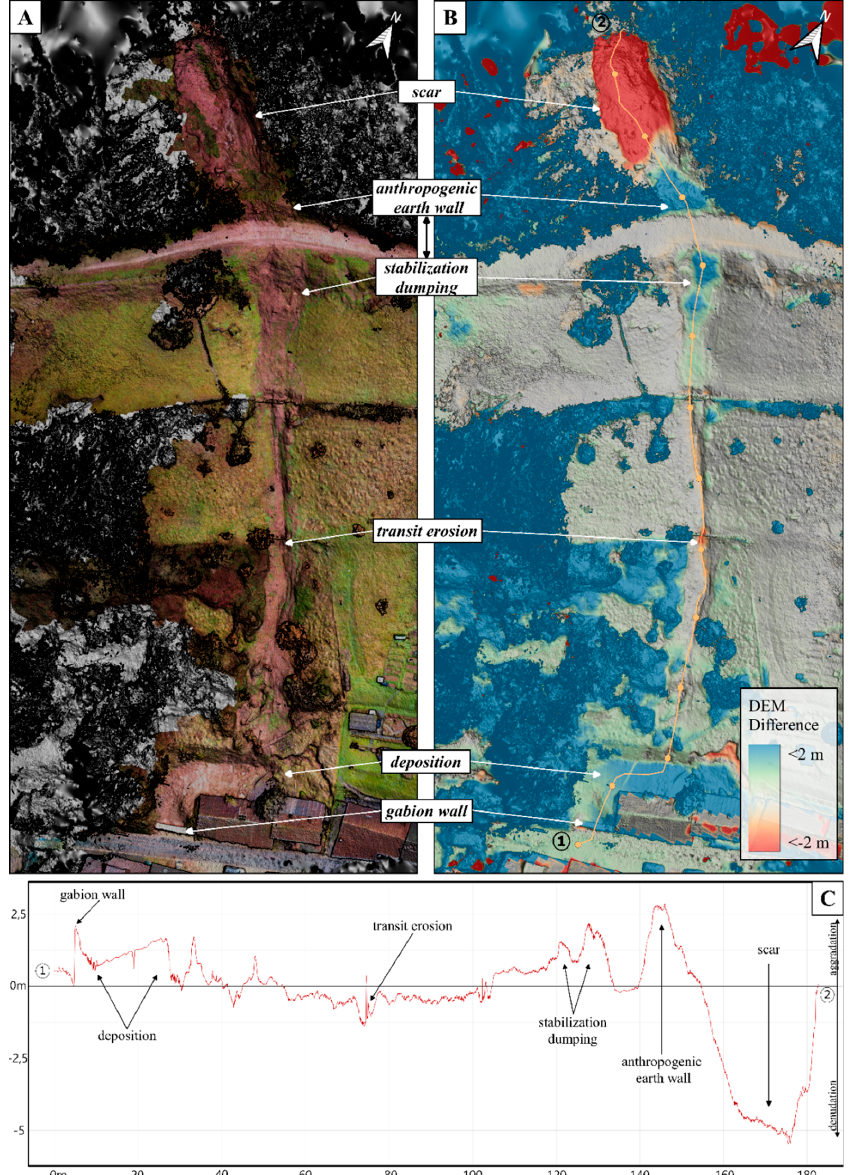
Figure 4. ( A ) Photogrammetrically-calculated model of the hillslope debris flow with overlying true-color mesh; densely vegetated areas marked in grey. ( B ) Elevation difference between the photogrammetrically-generated DEM from 2 February 2022 and an ALS-generated DEM from 2018. ( C ) Elevation change in the drawn transect (yellow line in B) with distinct morphological markers shown as 2D graph.